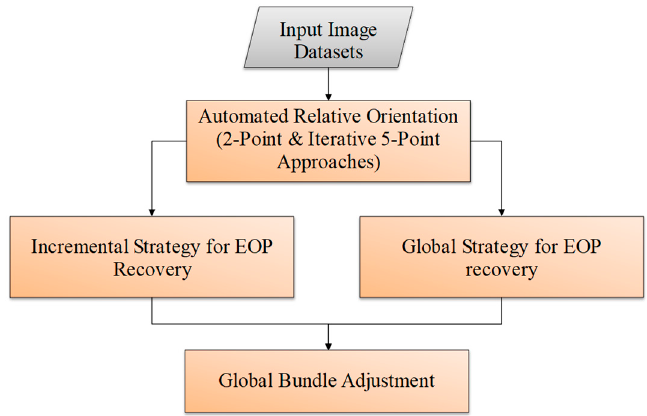
Figure 2. The proposed framework for the automated aerial triangulation of unmanned aerial vehicle (UAV)-based imagery.